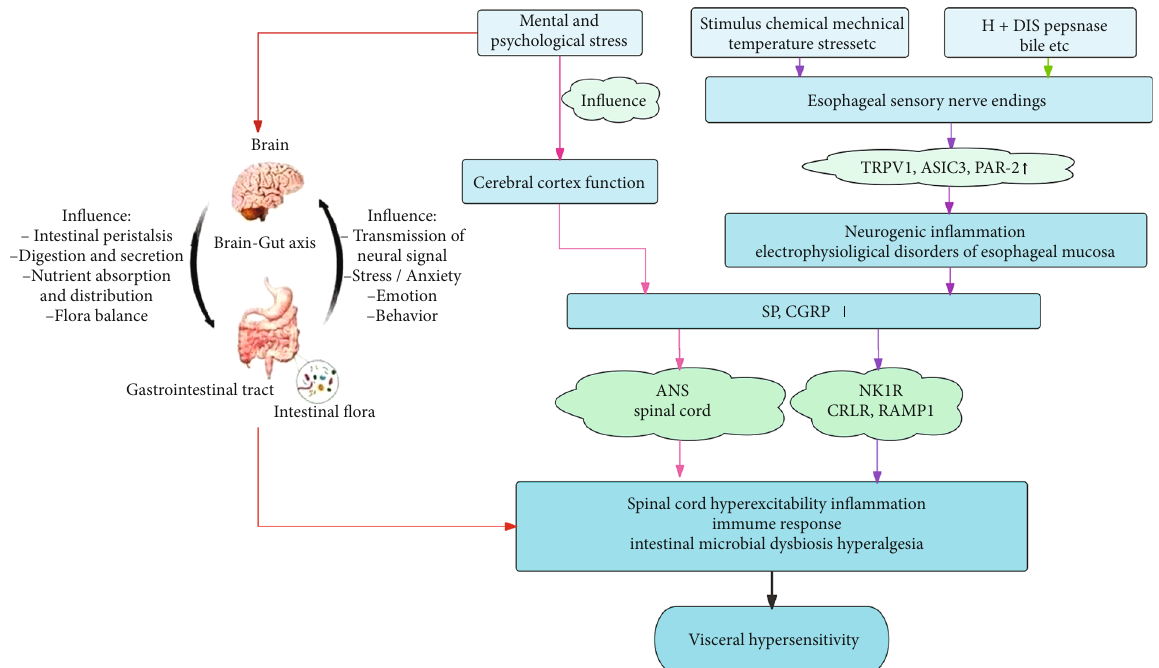
Figure 1: Endogenous or exogenous stimulation can activate acid-sensitive receptors, a ff ect the function of the cerebral cortex, activate the brain-gut axis, and eventually lead to central hyperexcitability, in fl ammation, immune response, hyperalgesia, and intestinal microbial disorders through the release of neuropeptides (SP and CGRP) or brain-gut peptides. These factors jointly play an important role in the VH of